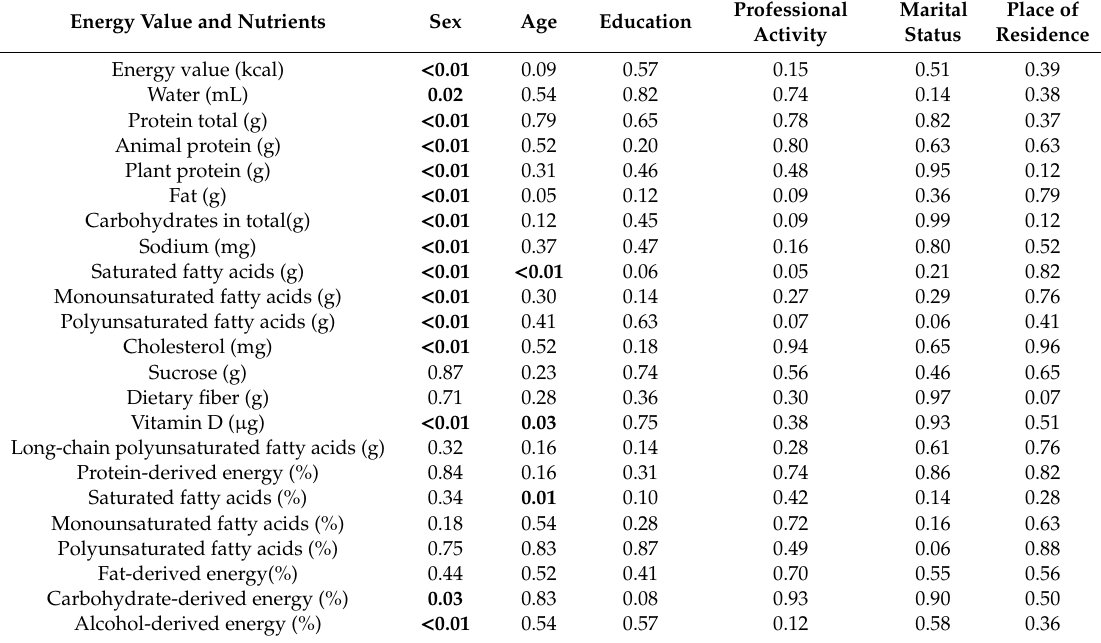
Table 4. Comparative analysis between the selected nutrients depending on sex, age, and sociodemographic